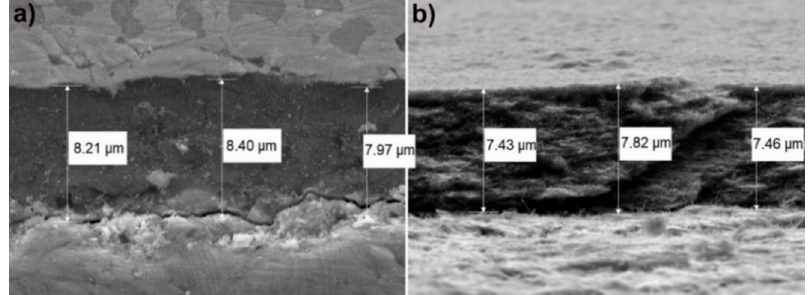
Figure 2. SEM images of Ti13Nb13Zr alloy MWCNTs coatings. ( a ) Cross-section; ( b ) fracture, with indicated measured thicknesses at three different points. Materials 2020 , 13 , x